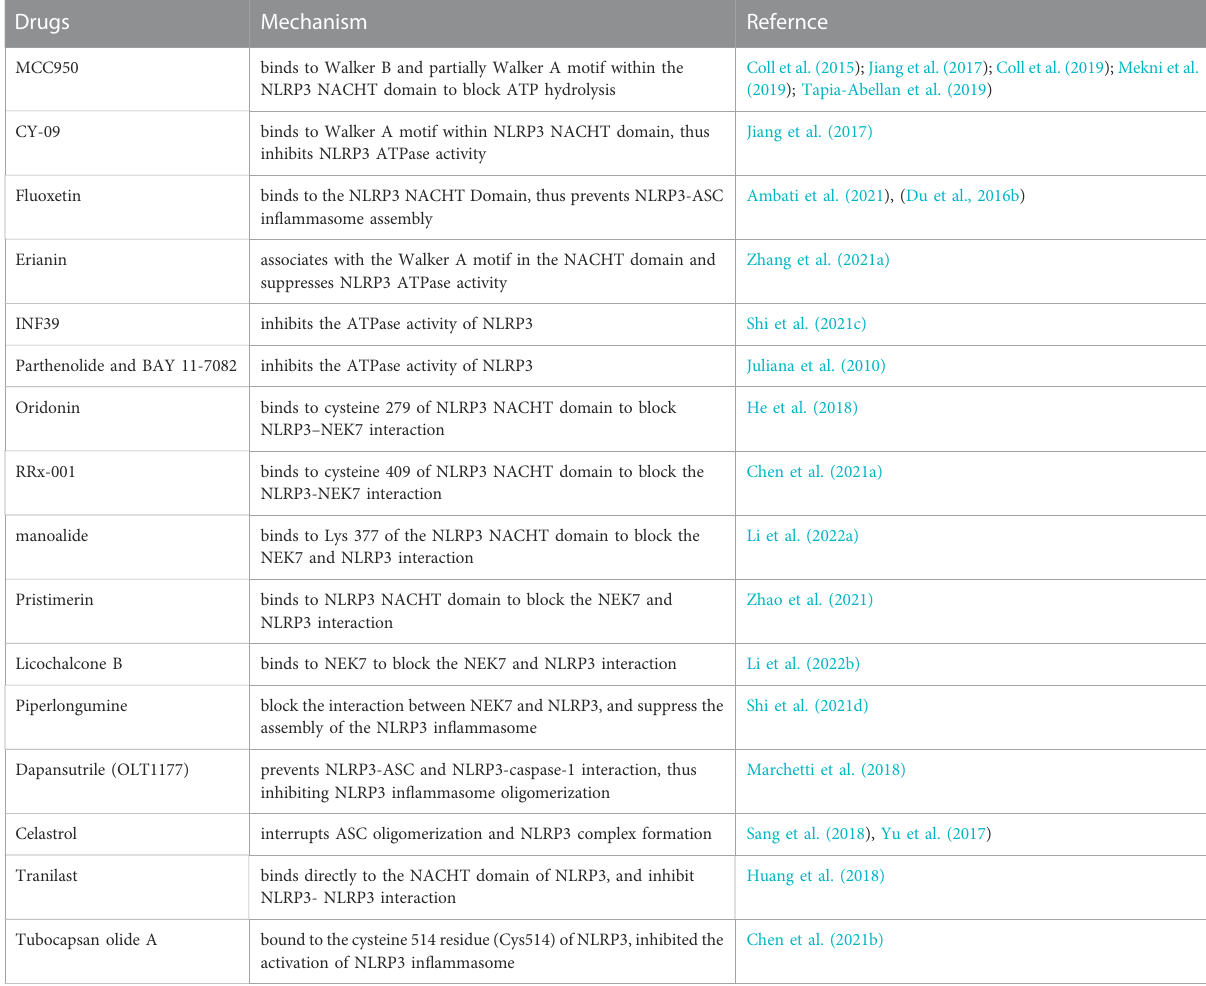
TABLE 1 inhibitors of NLRP3 in fl